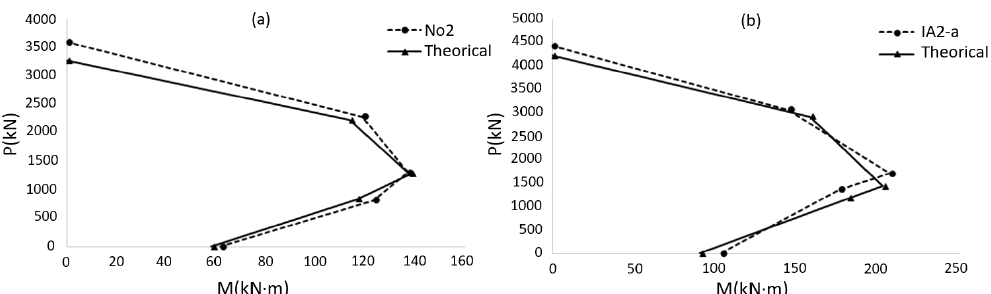
Figure 7. Interaction curves developed using the proposed procedure in this paper and those derived from experimental results of Reference [7] (a) No2 interaction curve; (b) IA2 ‐ a interaction curve.